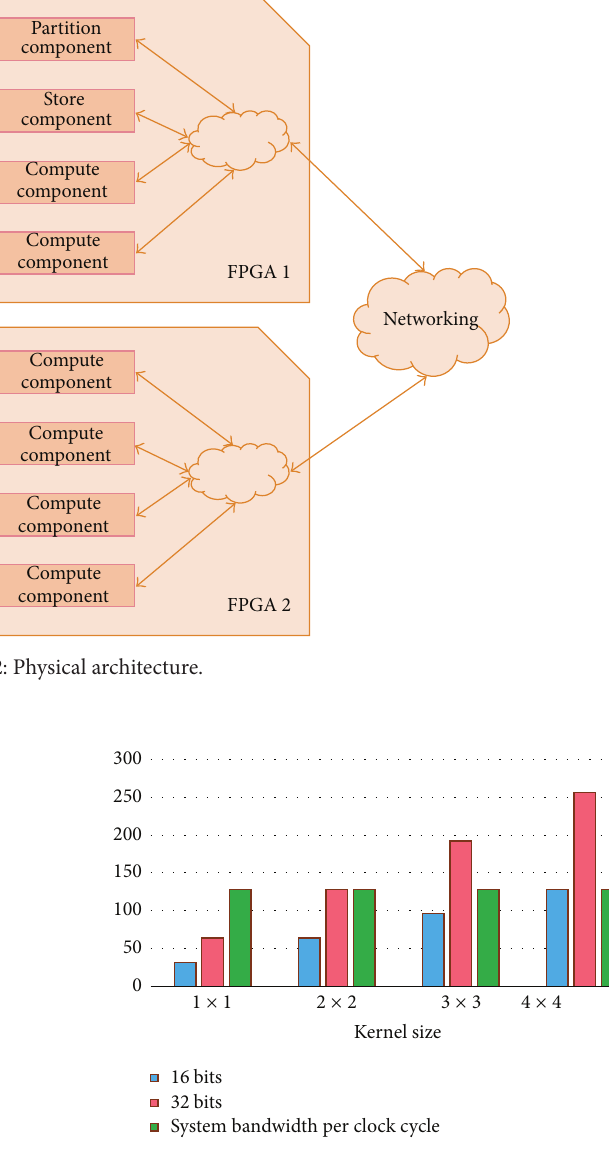
Figure 14: Memory bandwidth requirements per